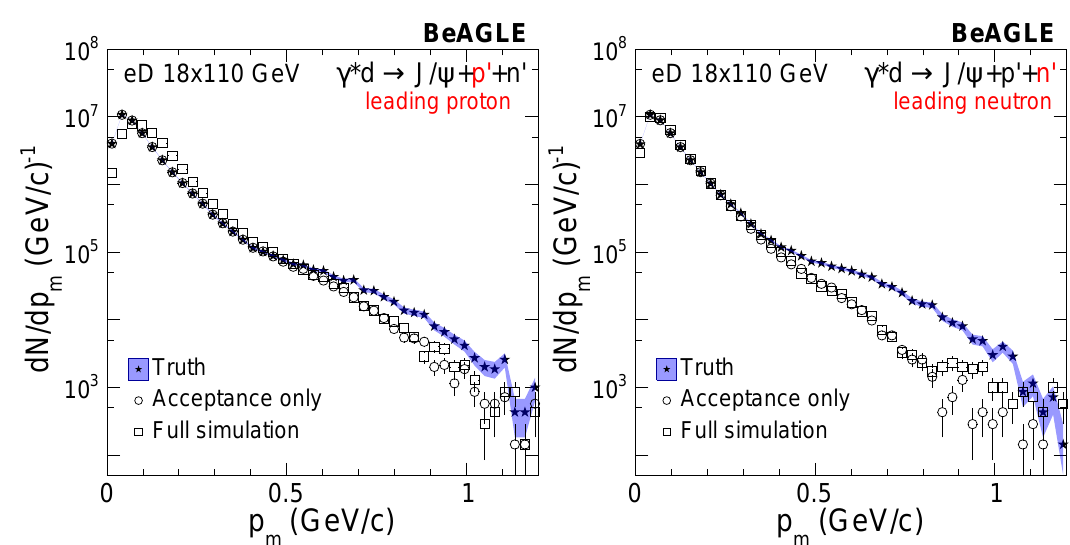
Figure 2: Distribution of the three-momentum of the spectator nucleon in events associated with incoherent diffractive J /ψ vector meson production in ed collisions are shown for the BeAGLE event generator. The left panel is for the neutron specta- tor case, where the right panel is for the proton spectators. The simulations at the generator level, with acceptances effects only, and for the full simulations, are shown with solid, open circles, and open squared markers,